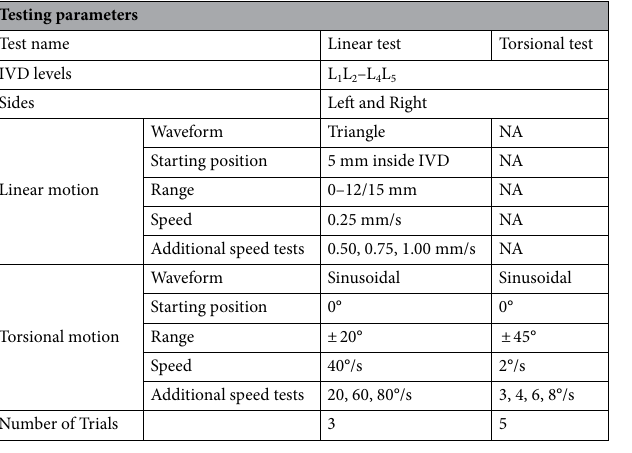
Table 2. Testing